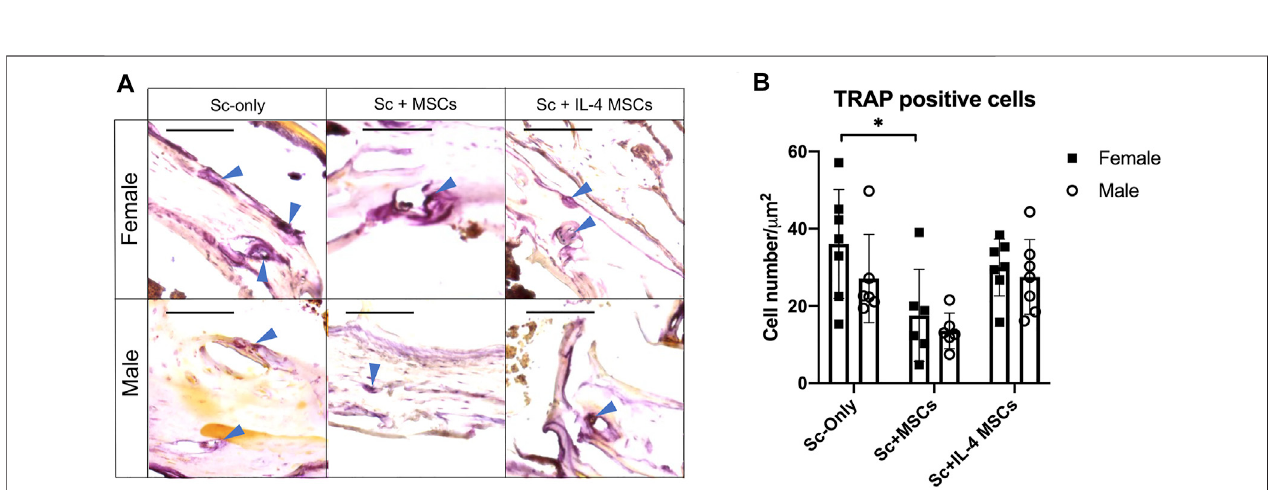
FIGURE 5 | TRAP staining and analysis of critical size bone defect healing after 6 weeks in female and male mice. (A) The TRAP-stained bone defects representative images of all groups with 200 times magni fi cation (red arrows showed the TRAP positive cells, bar (cid:2) 100 µm). (B) TRAP positive cell number calculated per µm 2 . *: 0.01 ≤ p <